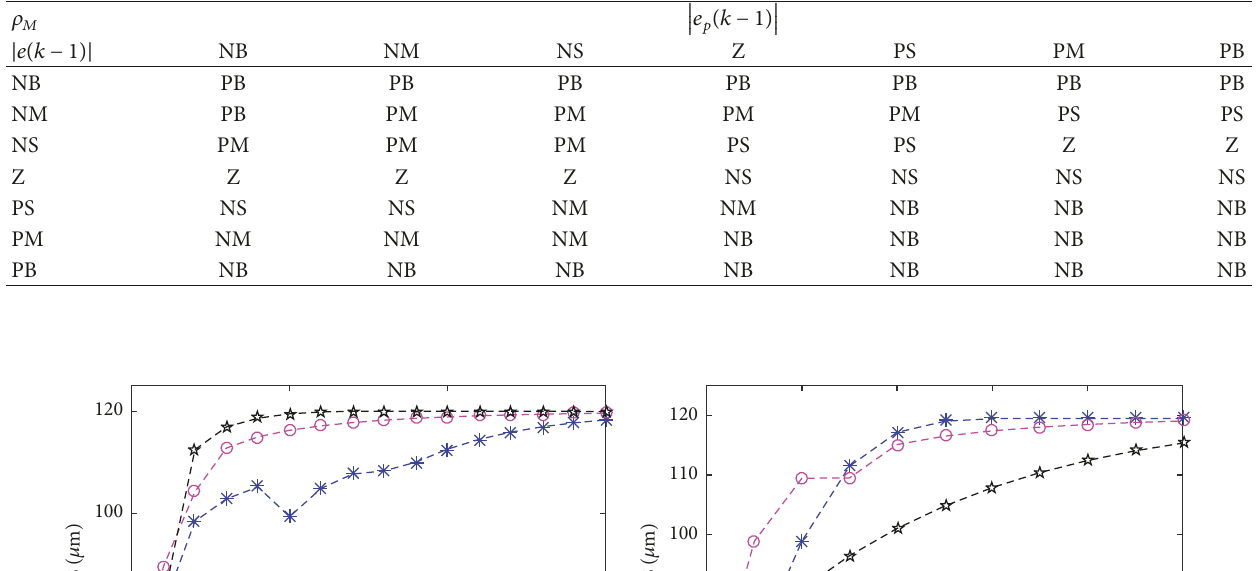
Table 4: The fuzzy rules of 𝜌 𝑀 .